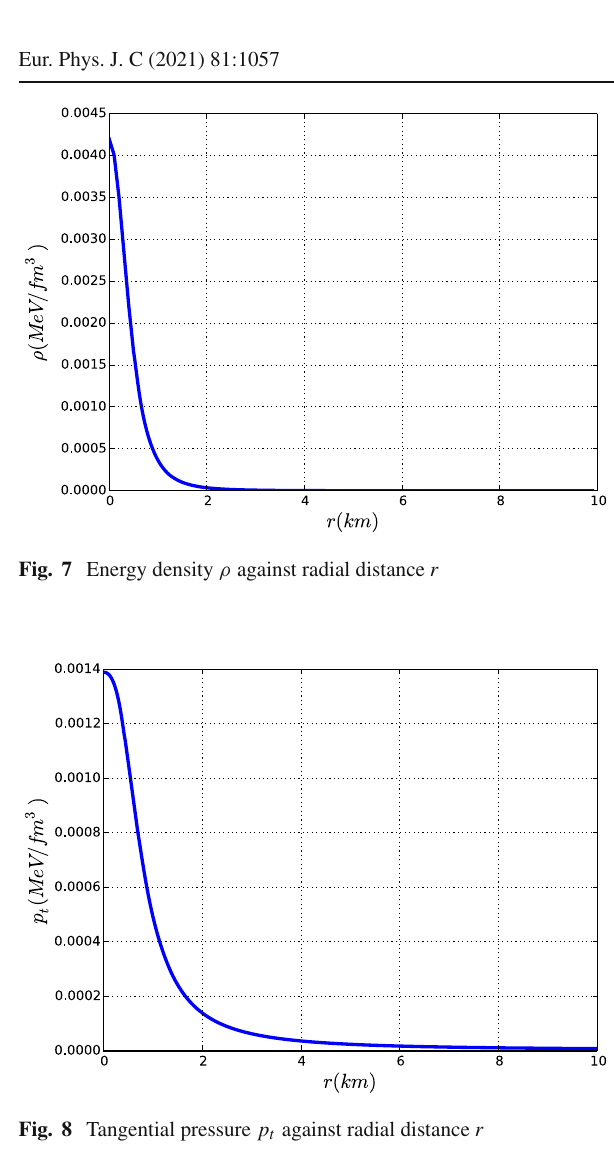
Fig. 8 Tangential pressure p t against radial distance r